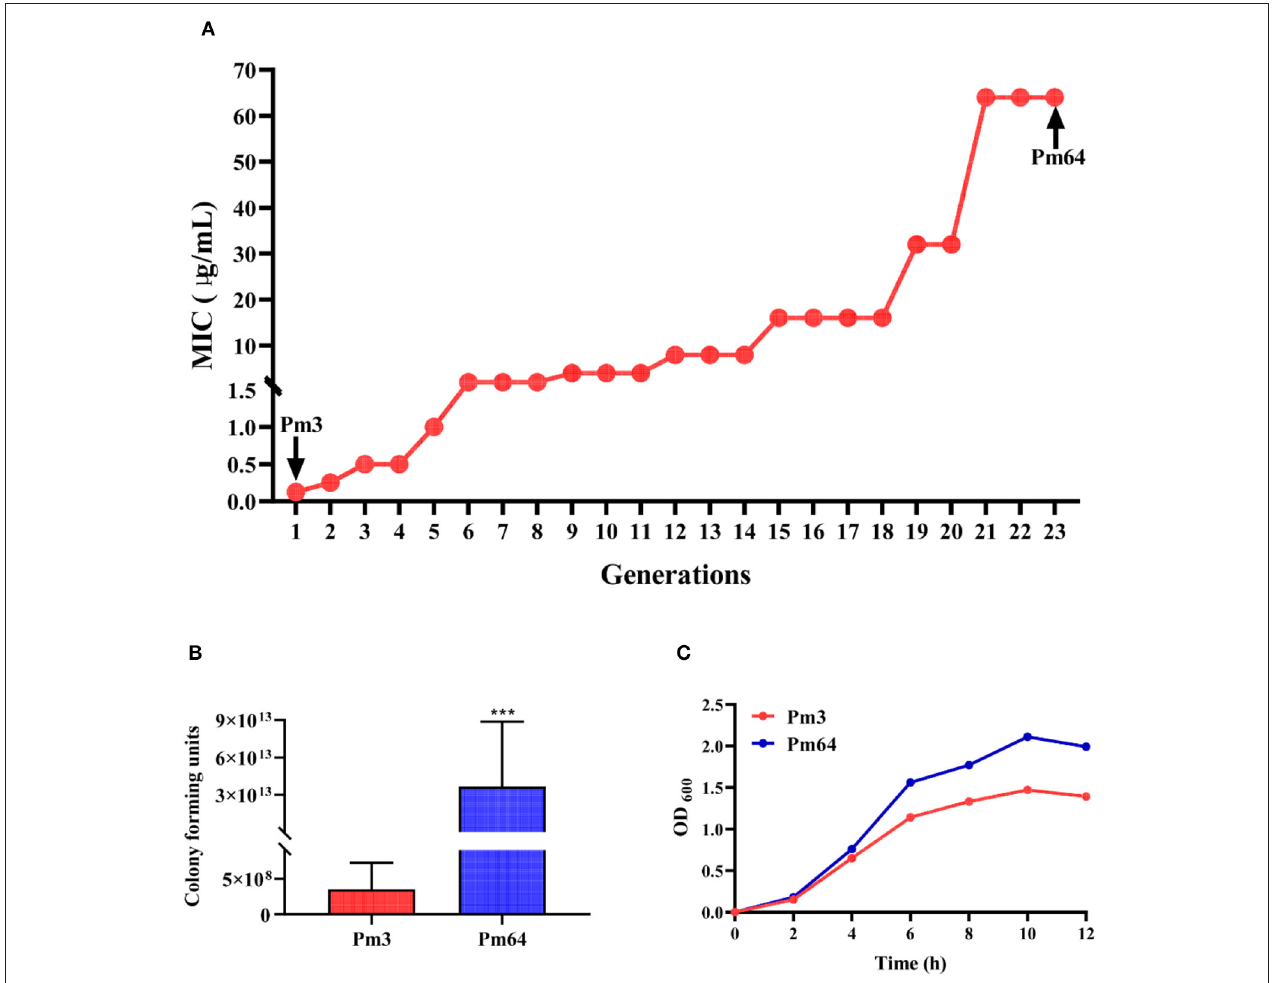
FIGURE 1 | Biological characteristics of Pm3 and Pm64. (A) Induction process of Pm64 from Pm3 strain under continuous increasing subinhibitory concentration (1/2MIC) enrofloxacin culture condition. (B) LD 50 of Pm3 and Pm64 to mice. (C) Growth curve of Pm3 and Pm64 (*** p <